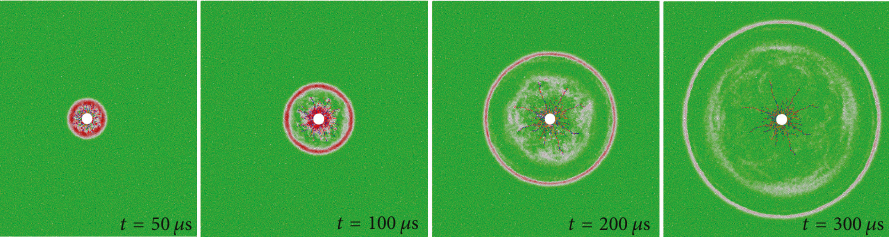
Figure 7: Transmission of stress waves.